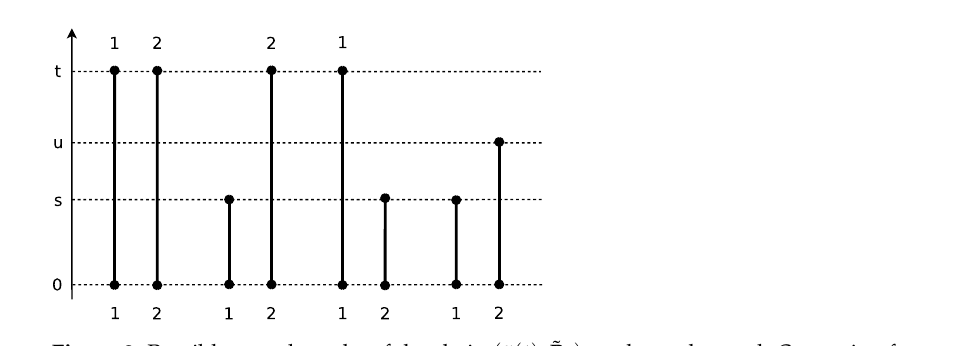
Figure 2. Possible sample paths of the chain ( ˜ a ( t ) , ˜ P a ) on the cycle graph C 4 starting from e 1 + e 2